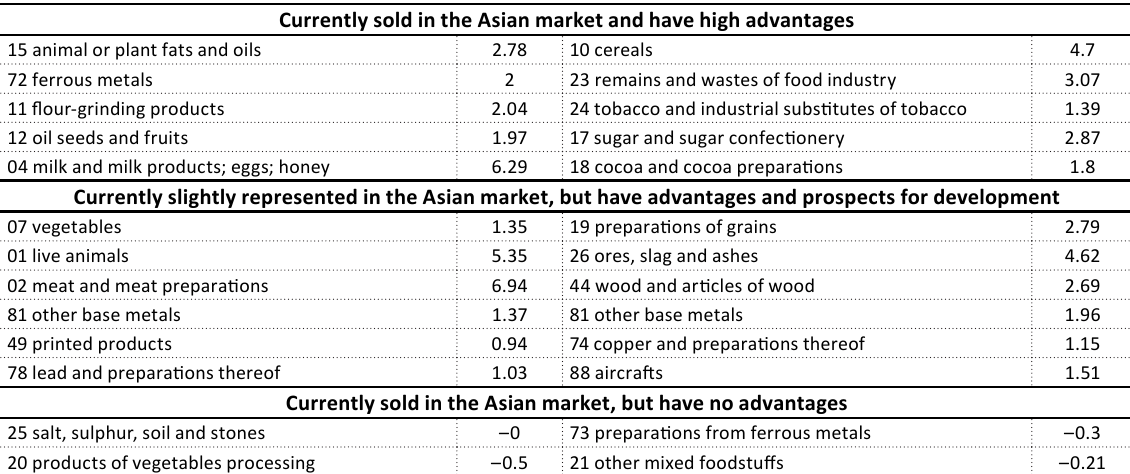
Table 3. Priority commodity groups of Ukraine’s exports for sale in the Asian market by the criterion of relative advantages